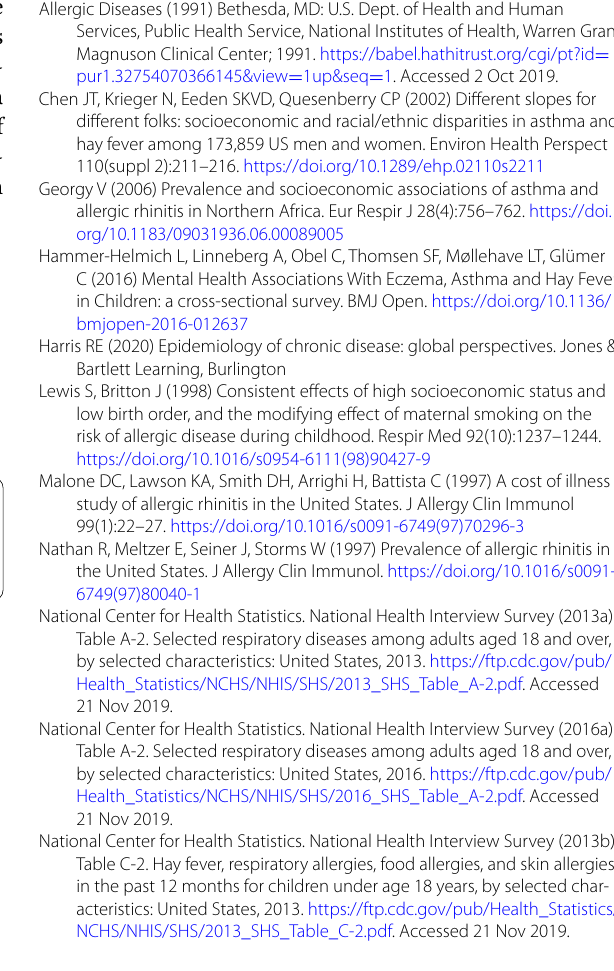
Table A-2. Selected respiratory diseases among adults aged 18 and over, by selected characteristics: United States, 2016. https:// ftp. cdc. gov/ pub/ Health_ Stati stics/ NCHS/ NHIS/ SHS/ 2016_ SHS_ Table_A- 2. pdf. Accessed 21 Nov 2019. National Center for Health Statistics. National Health Interview Survey (2013b) Table C-2. Hay fever, respiratory allergies, food allergies, and skin